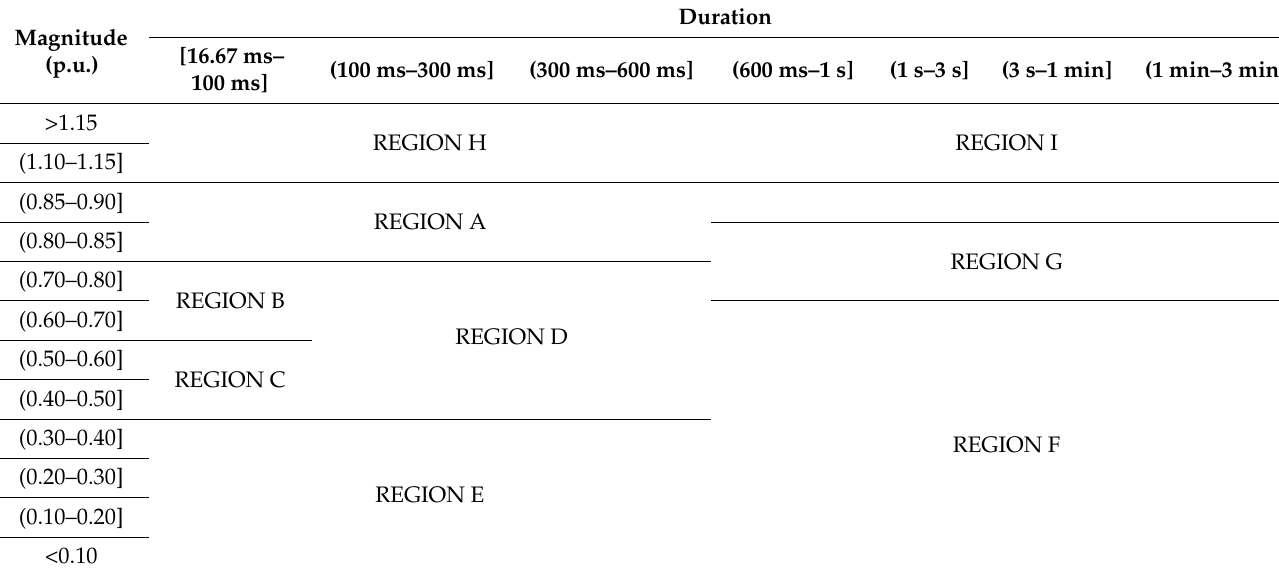
Table 1. Stratification based on sensitivity levels of various